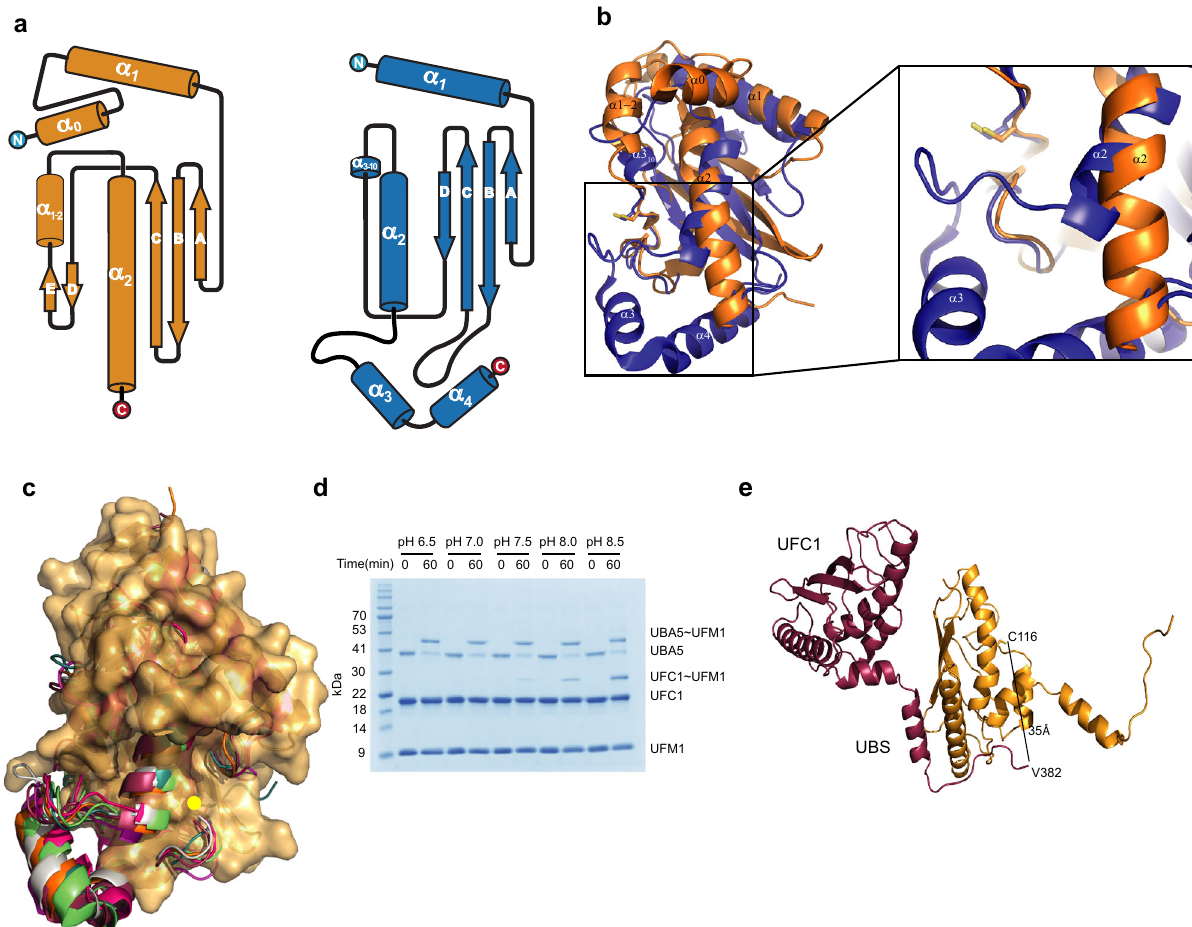
Fig. 3 UFC1 lacks a structural loop adjacent to the active site Cys. a . Topology depictions of UFC1 (orange) and UBC9 (blue) secondary structure elements. b Superposition of UFC1 (orange) with UBC9 (blue). Helices are numbered as shown in a . Active site Cys residues of UBC9 and UFC1 are in stick representation. c Superposition of UFC1 (surface representation) with seven different E2s (UBCH5b (3TGD), UBC9 (5F6E), UBC13 (1J7D), UBCH5c (1X23), E2E2 (1Y6L), UBCH7 (4Q5E), UBCH10 (4YII)) in cartoon representation. E2s are colored as shown in Supplementary Fig. 7. The yellow dot indicates the position of the active site Cys. d SDS − PAGE analysis showing the effect of pH on UFM1 transfer to UFC1 from UBA5 1 – 363. The gel is representative of at least two independent experiments. e Crystal structure of UFC1 fused to UBA5 residues comprising the linker and UBS (347 – 404). The fi gure shows two molecules while the UBS of the red molecule interacts with the UFC1 that arrives from the yellow molecule. Residues 347 – 381 of UBA5, although present in the crystal, are not shown in the structure due to a lack of electron